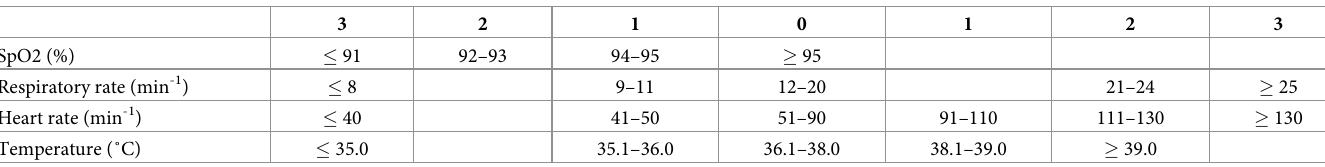
Table 1. Modified national early warning score